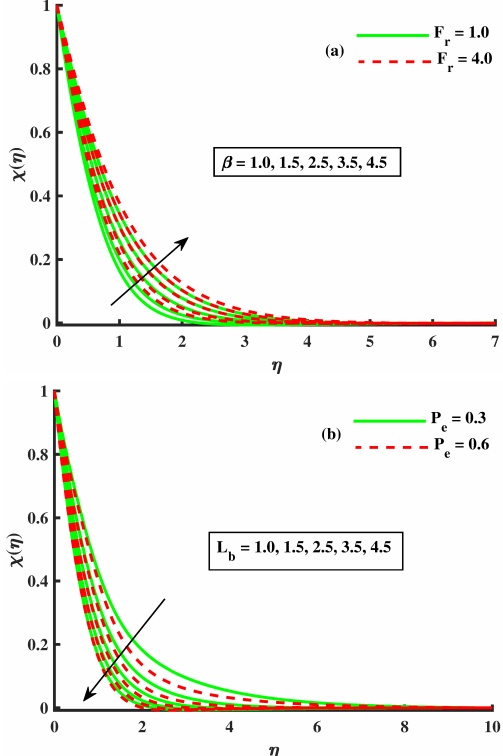
Figure 10. The effects of β , F r , L b ,& P e on χ ( η )